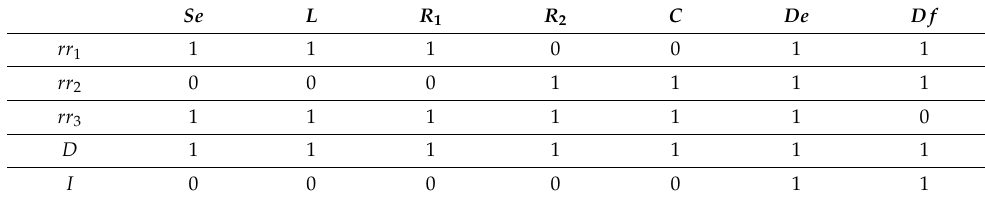
Table 1. Table of electrical system fault